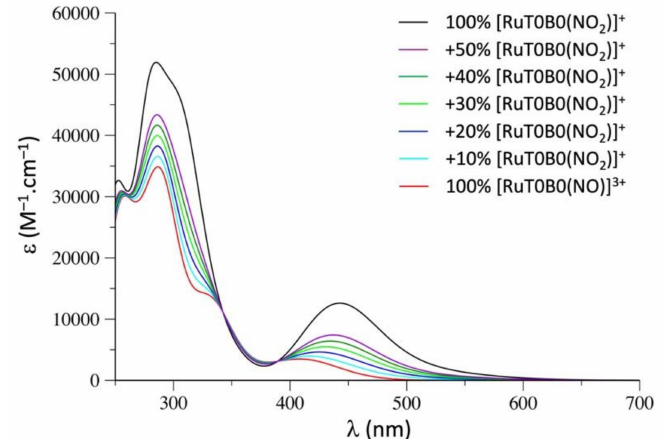
Figure 4. Simulated UV-vis absorption spectra of [RuT0B0(NO)] 3 + (red curve) and of [RuT0B0(NO 2 )] +